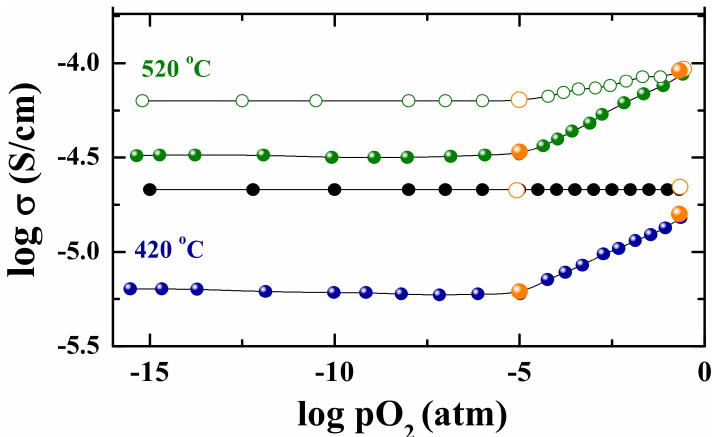
Figure 8. Oxygen partial pressure dependencies of the total conductivity for the BaNd 2 In 2 O 7 sample at dry (filled symbols) and wet (open symbols) conditions and conductivity values from σ –10 3 / T dependencies (orange symbols).